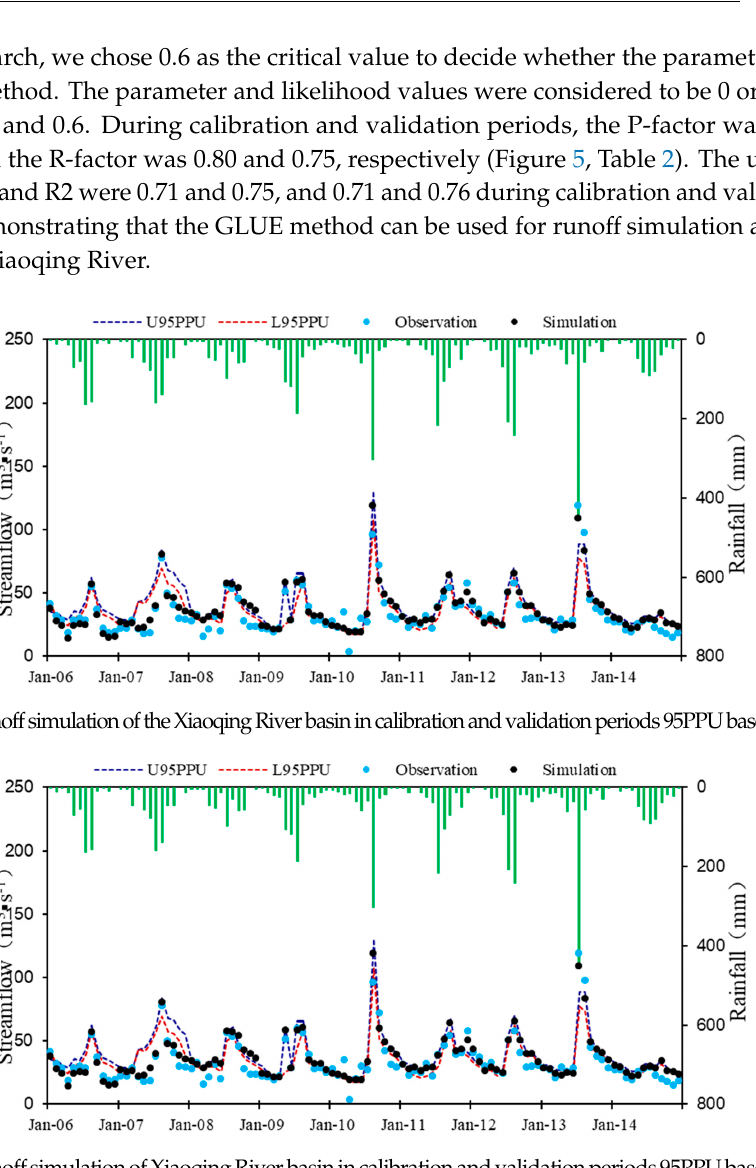
Figure 5. Figure 5. Runoff simulation of Xiaoqing River basin in calibration and validation periods 95PPU based on GLUE.